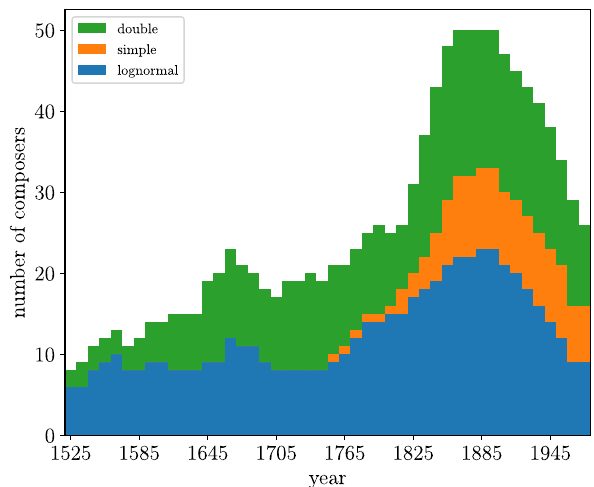
Figure 8. Number of composers best fitted by each fit, as a function of year (year is determined as the mean between birth plus 20 and death). Numbers have been smoothed: for each interval of 10 years we take a window of 150 years and count the number of fits in the